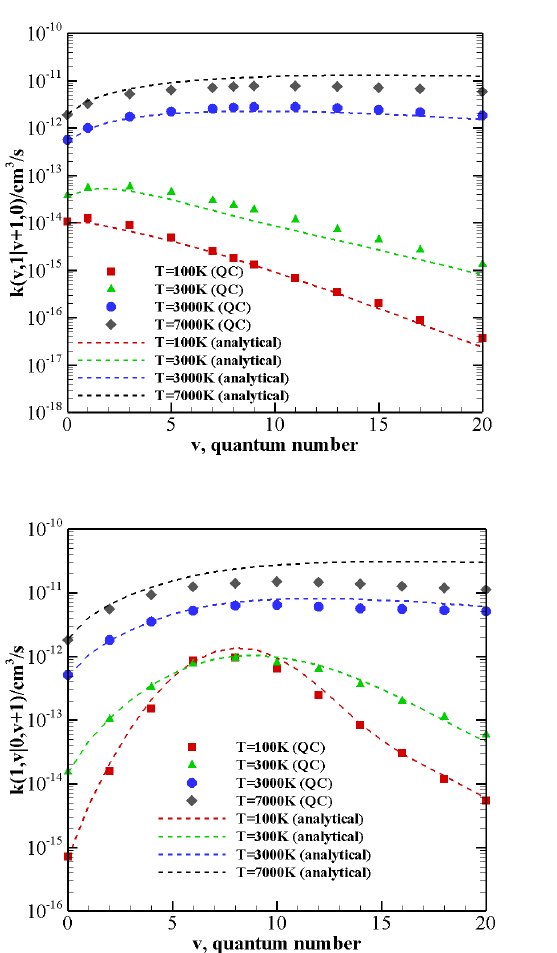
Figure 6. Rate coefficients for the V–V transitions as a function of the vibrational quantum number v at different temperature values. ( upper panel ) CO ( v ) + N 2 ( 1 ) → CO ( v + 1 ) + N 2 ( 0 ) ; ( lower panel ) CO ( 1 ) + N 2 ( v ) → CO ( 0 ) + N 2 ( v + 1 ) . Dash lines correspond to the analytical rate coefficients obtained by the modified SSH theory (Appendix